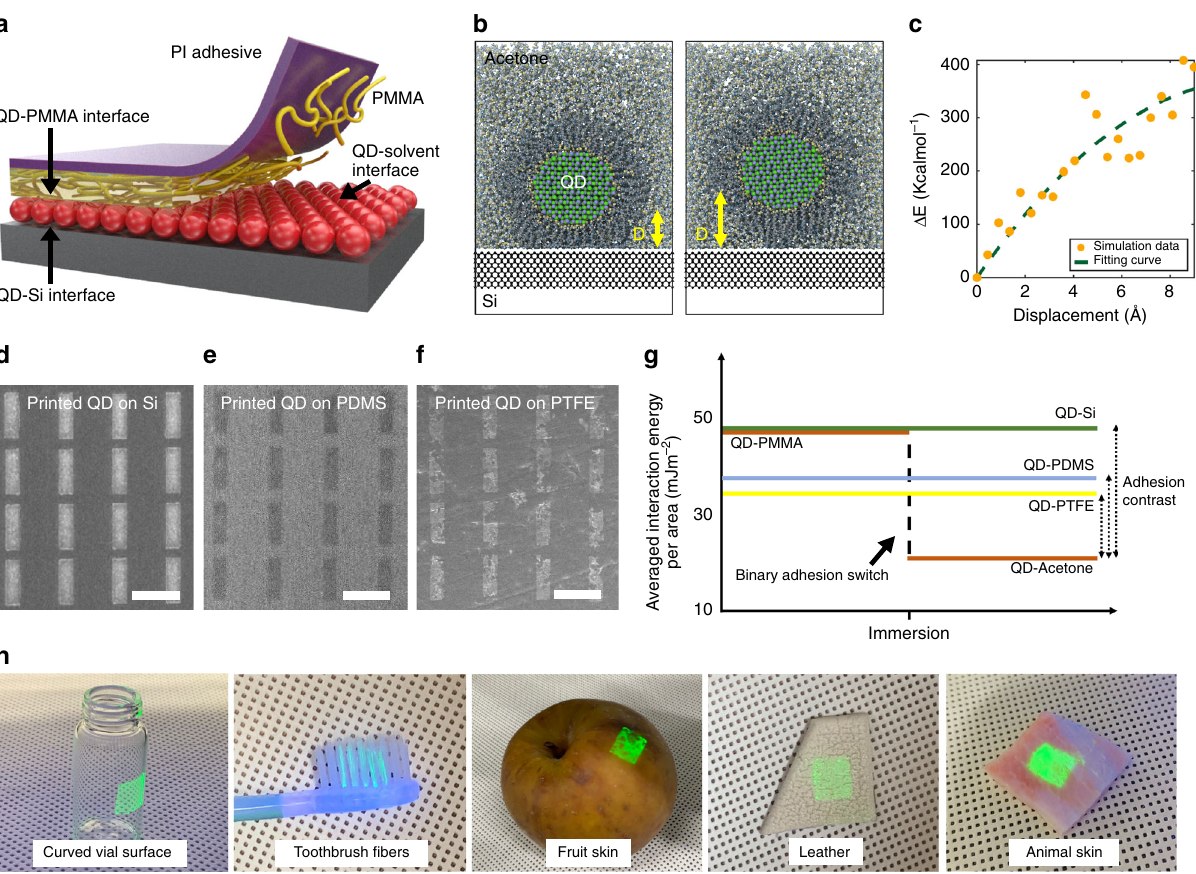
Fig. 4 Non-kinetic iTP mechanism. a Illustration of adhesion switch after PMMA dissolution in iTP mechanism. b MD simulation results of contacted (left) and lifted (right) QDs from the Si surface with a displacement D, when surrounded by acetone. c The simulation data of the excess energy necessary to lift the QD from the Si surface by the displacement D, is plotted and fi tted. d – f SEM images of transferred QD arrays using pressure-free iTP on Si surface ( d ), PDMS surface ( e ), and PTFE surface ( f ). The printing demonstration on PDMS and PTFE surface indicate reversed predominance of adhesion via binary adhesion switching principle. Scale bars denote 10 µ m. g The averaged interaction energy per area of the QD-media interfaces are calculated using MD simulation to illustrate the hypothetical relationship of adhesion in each interface as the PMMA dissolves during immersion. h QD pattern fi lms printed on various surfaces with different curvature, topography, and